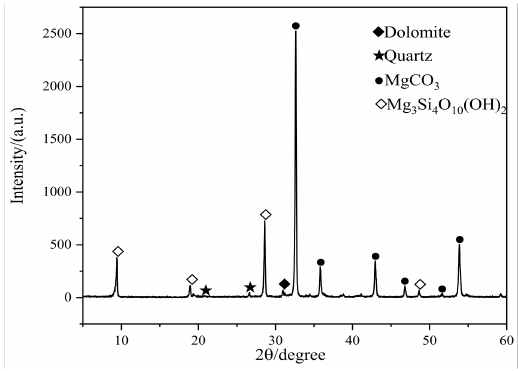
Figure 2. X-ray diffraction patterns of OSP.